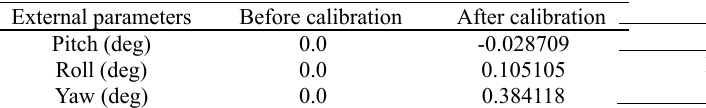
Figure. 4 Internal distortion surface of intermediate infrared sensor Table 6. Accuracy of the calibration of intermediate